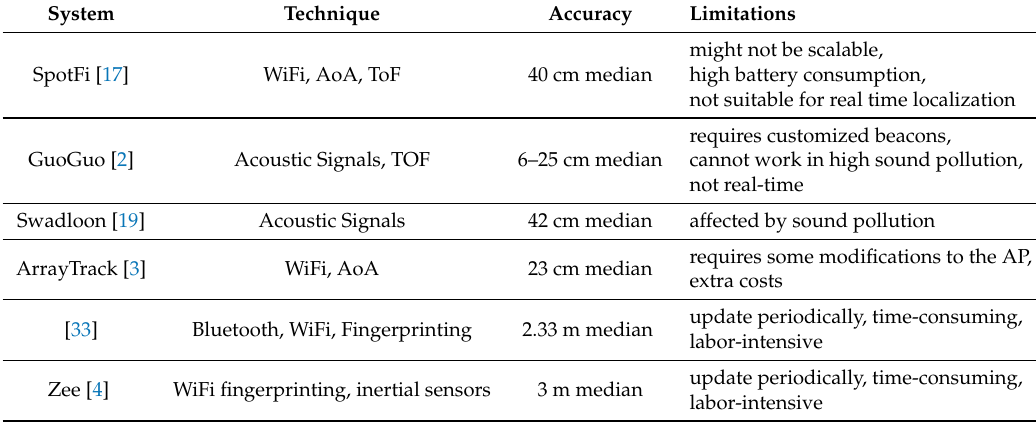
Table 1. Accuracy comparison with different localization